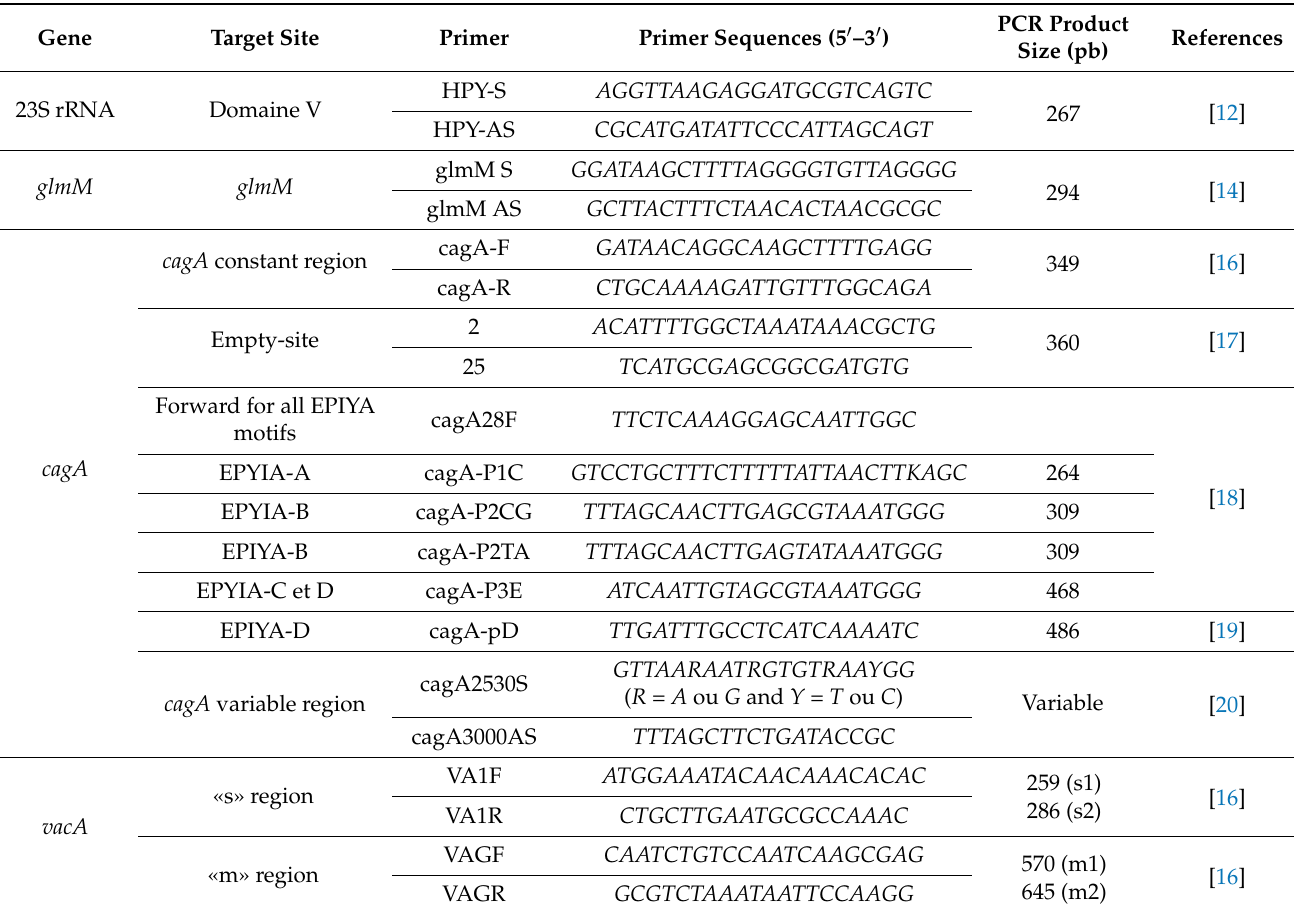
Table 1. Primer sequences used in this